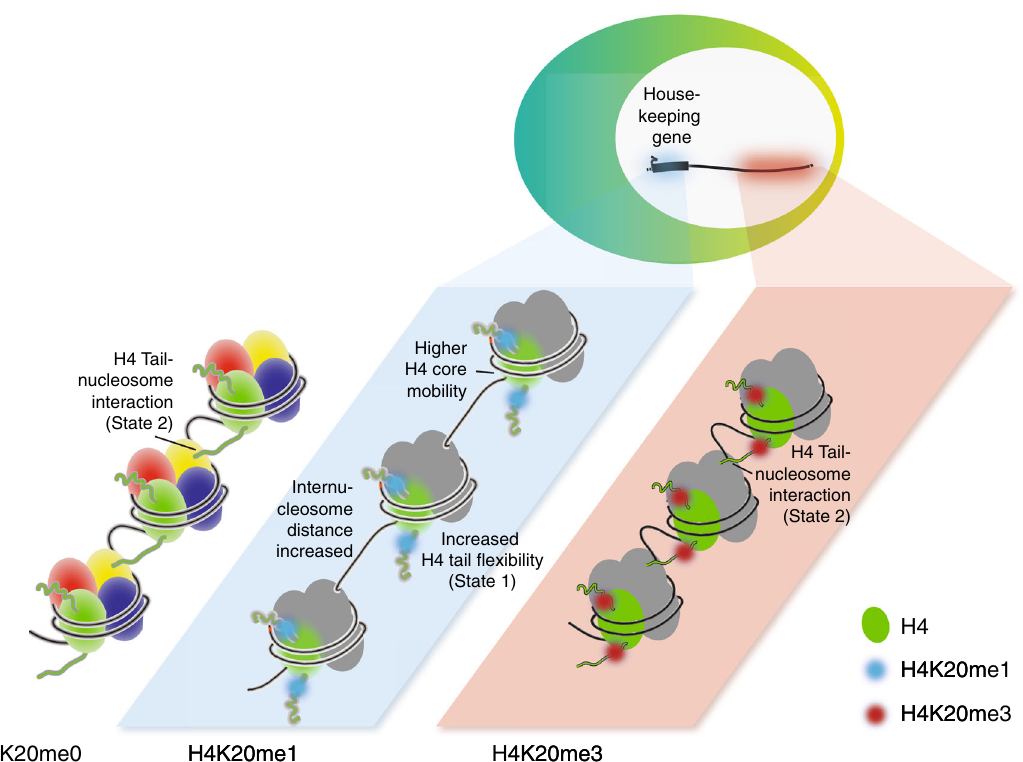
Fig. 7 SET8-H4K20me1 pathway promotes housekeeping gene transcription through chromatin structure modulation. Detailed model depicting the chromatin conformation at ( i ) state 1 and (ii) state 2. In state 1, transcription of housekeeping genes is promoted by dynamic H4 tails having H4K20me1 enrichment creating an open chromatin environment. State 2 represents intergenic regions with more static H4 tails having H4K20me3 enrichment. This creates a more compact chromatin which is transcriptionally repressive. In the absence of SET8, expanding H4K20me0 regions promote H4 tails more similar to the H4K20me3 conformation (state 2) resulting in more compact chromatin environment repressive towards